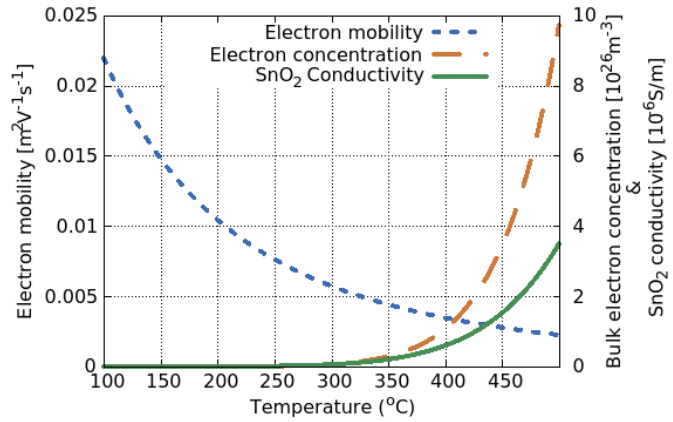
Figure 17. The influence of temperature on the electron mobility ( µ ), the electron concentration ( n ), and the SnO 2